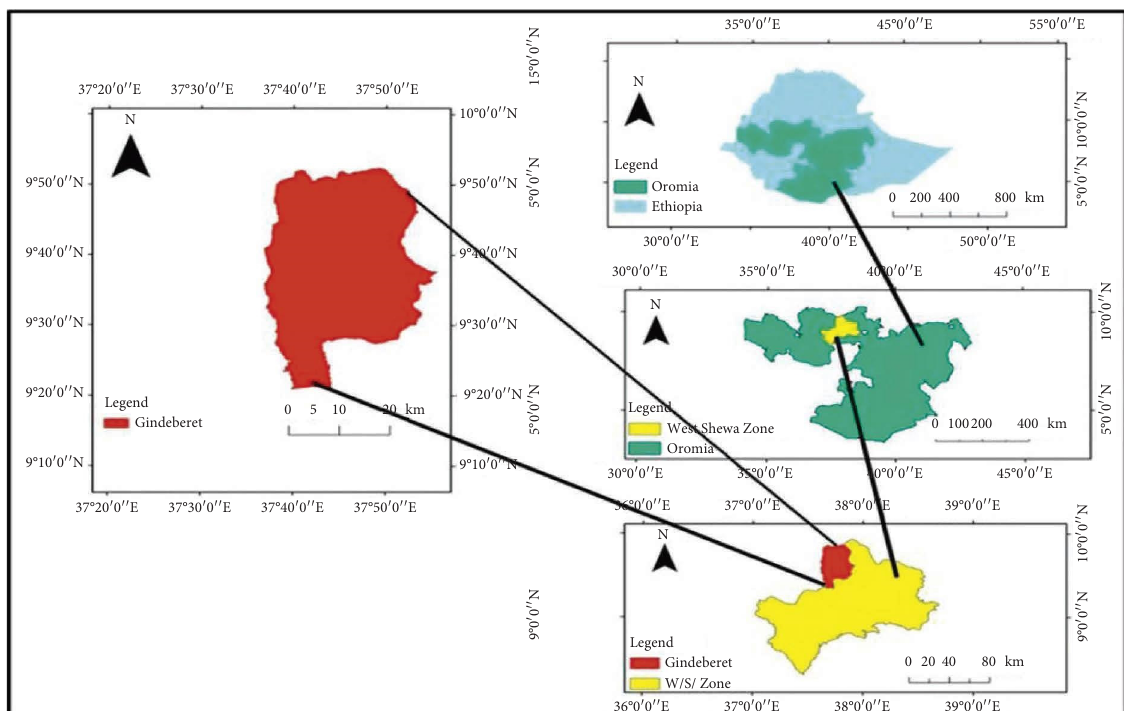
Figure 1: Map of the study area.